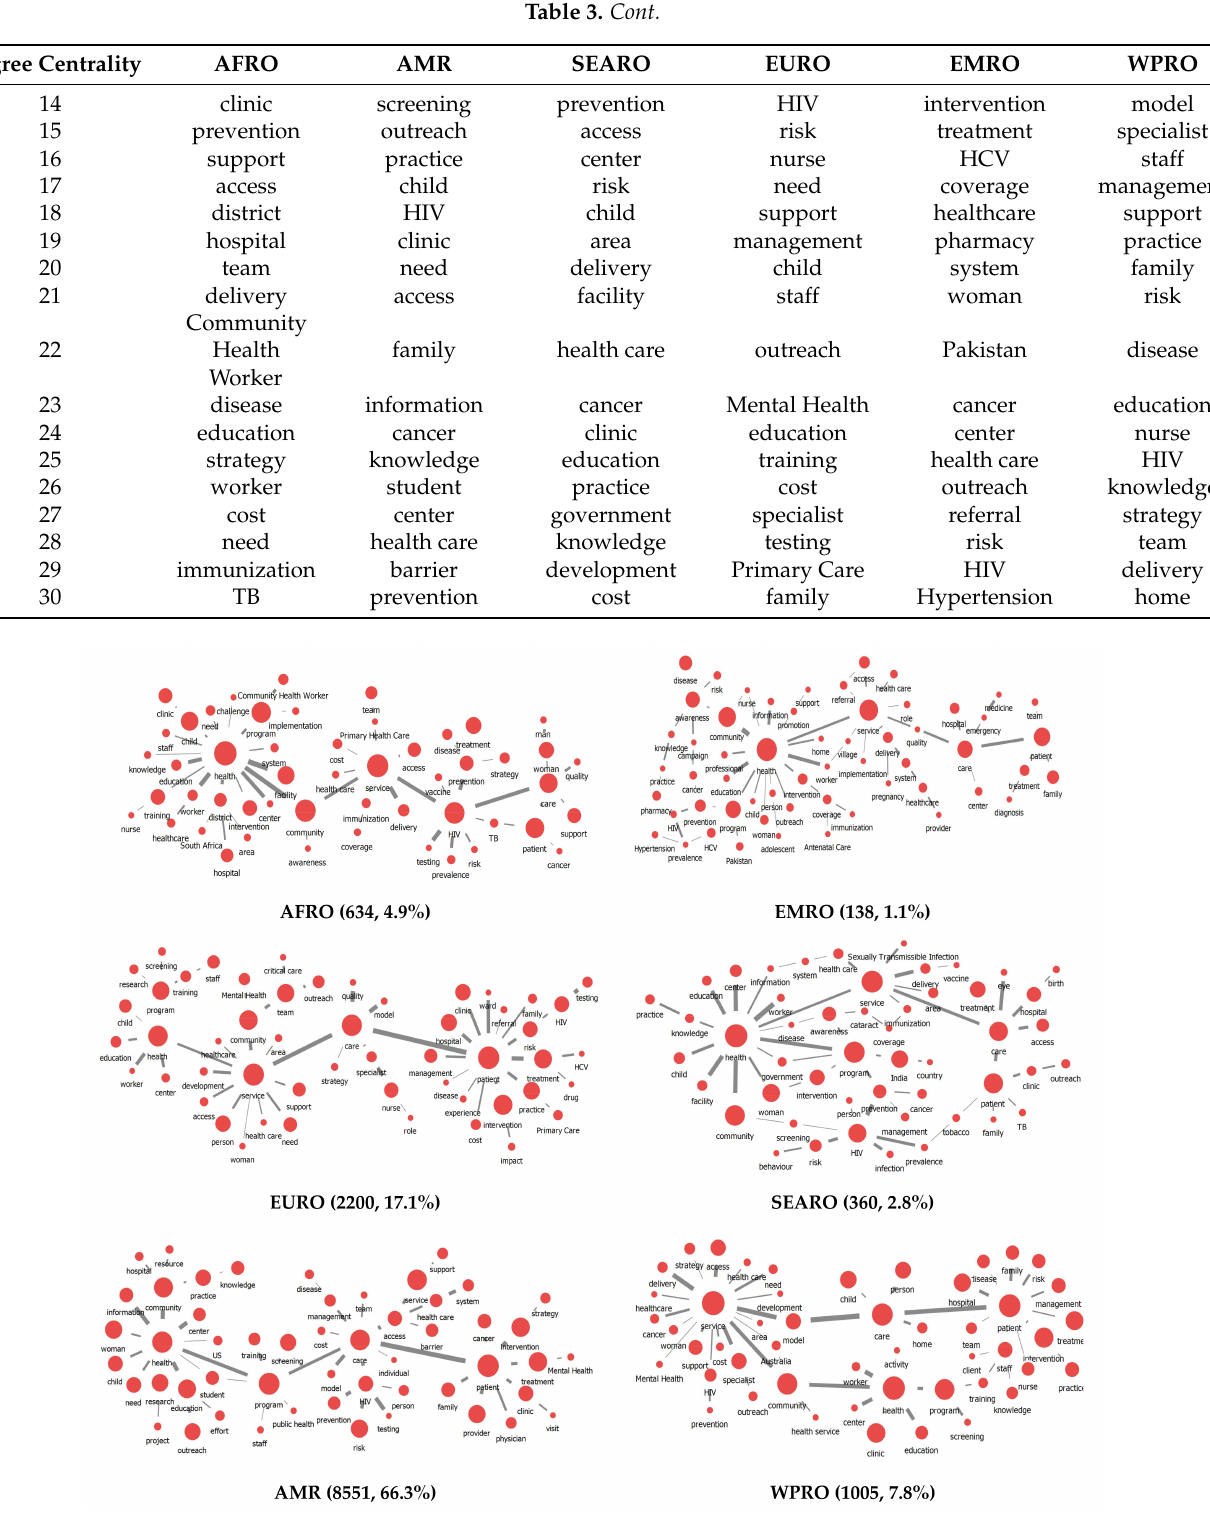
Figure 3. Knowledge structure of outreach research by each region. The size of the node indicates the degree centrality of the keyword, and the width of the line indicates the strength of the link between keywords; AFRO = African Region; AMR = Re- gion of the Americas, SEARO = South-East Asia Region; EURO = European Region; EMRO = Eastern Mediterranean Region; WPRO = Western Pacific